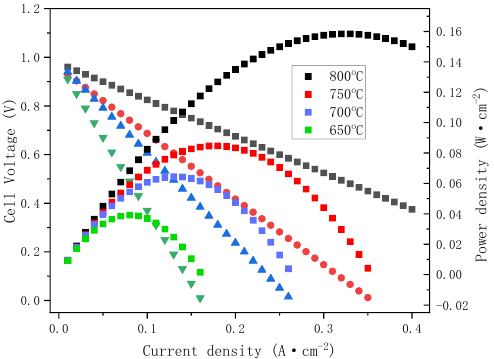
Figure 9. Single cell performance of a single IT-SOFC. NiO + CSYG-BIT07|LSCF + CSYG-BIT07 measured at 800 °C.